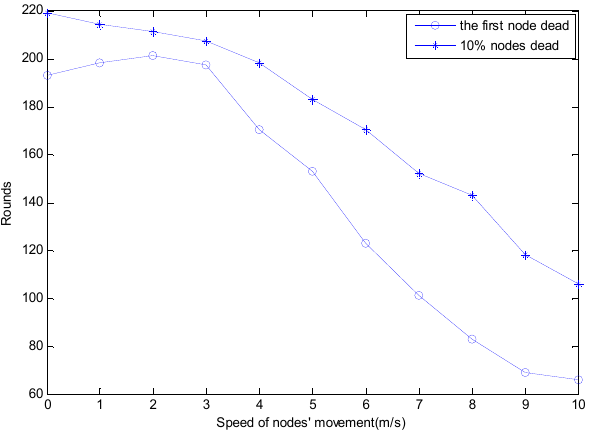
Figure 9. The influence of nodes’ speed on the network death time.